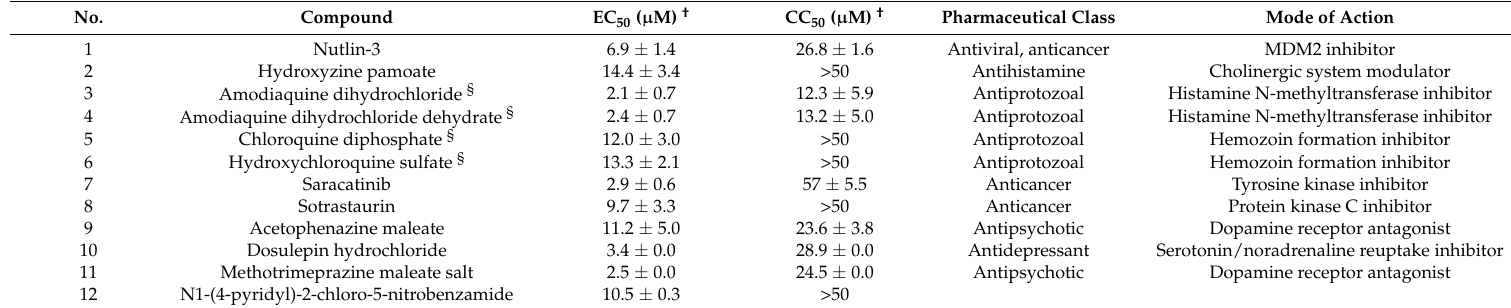
Table 1. Hit compounds with antiviral activity against